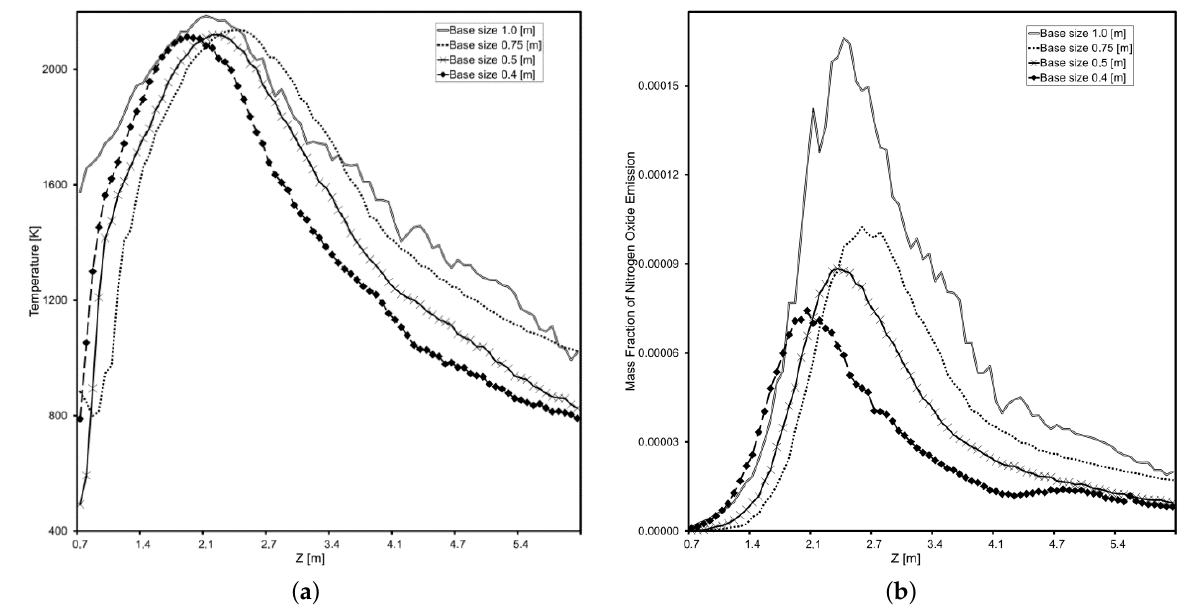
Figure 5. Comparison of test calculations for the combustion of a methane-air mixture with a “basic” size of cells of the computational grid of 0.4–1.0 m: ( a ) comparison of temperature; ( b ) comparison of NOx emissions. With a “basic” size of 0.4 m, the number of cells of the computational grid was 5,192,600; with a “base” size of 0.5 m–2,787,464; with a “base” size of 0.75 m–951,840; with a “base” size of 1.0